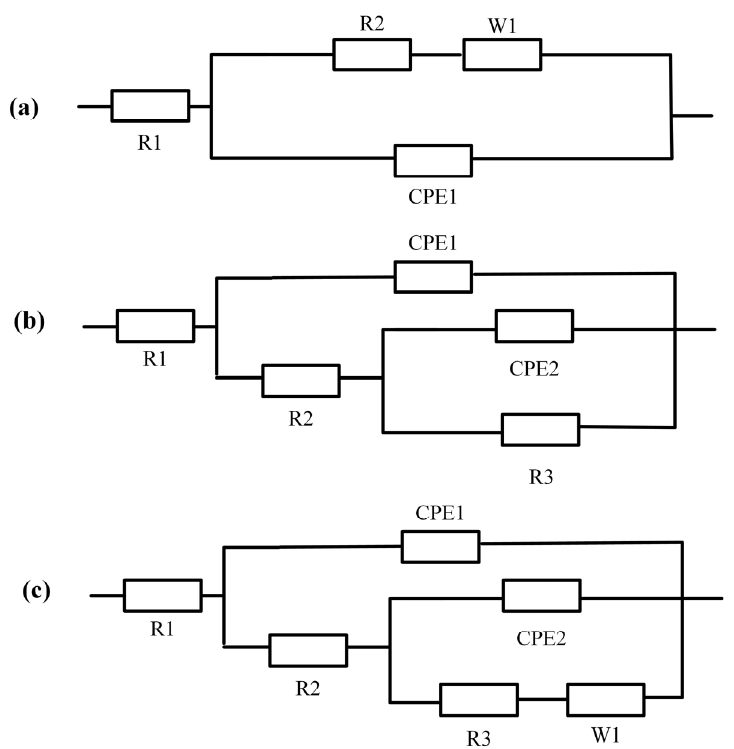
Figure 13. Equivalent circuit of steel electrodes with different coatings. ( a ) HAP (24 h) and ZnO-HAP (24 h), ( b ) pure epoxy resin (24 and 72 h), ( c ) HAP (72 h), ZnO (72 h) and ZnO-HAP (72 h).